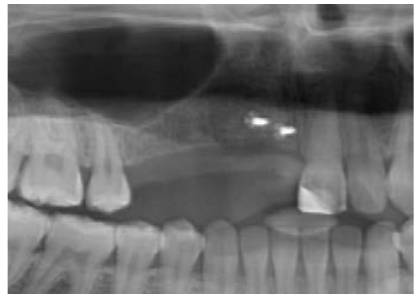
Figure 3. Panoramic radiographic investigation after fixation of the bone block. Surgeons: Dr. Stefan Roehling, Dr. Georges Ghazal (Image: Institute of Radiology, Kantonsspital Aarau, AG, Aarau, Switzerland).